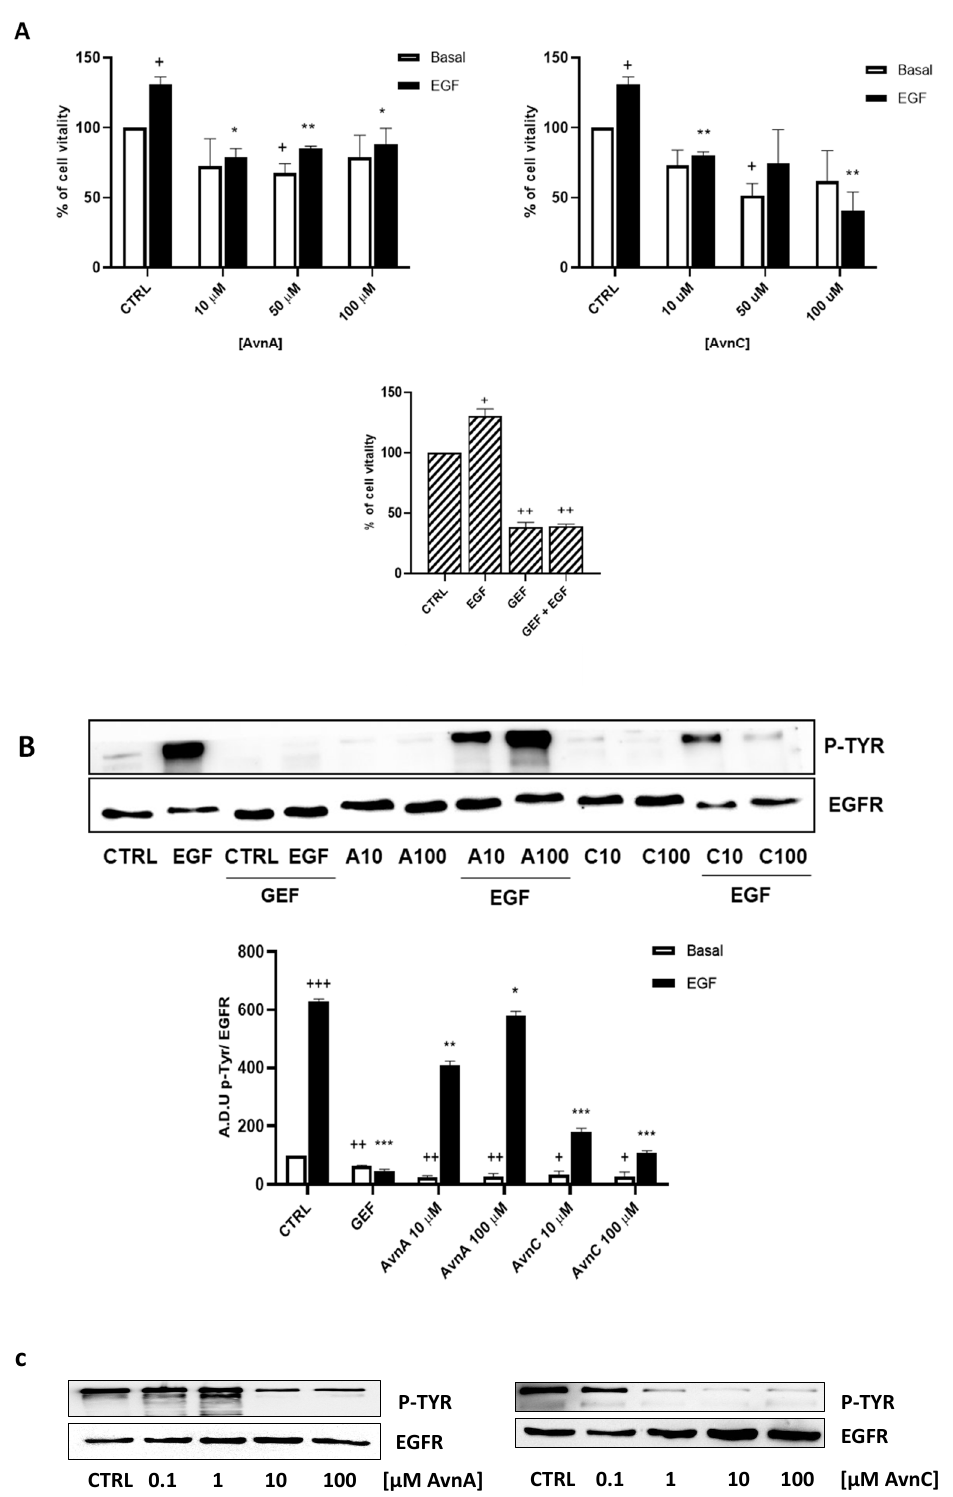
Figure 9. Effects of Avns on A431 cells vitality and EGFR phosphorylation. ( A ) MTT assay. Cells were exposed to EGF in the presence of increasing concentrations of Avns (10, 50, and 100 µ M) for three days. Data are expressed as % over basal control and are representative of three independent experiments run in triplicate. Statistical analysis: ++ p < 0.01 and + p < 0.01 vs. CTRL; ** p < 0.01 and * p < 0.05 vs. EGF. ( B ) EGFR phosphorylation. Representative images and quantification of western blot analysis in A431 cells treated with EGF in presence or absence of Avns (10 and 100 μ M). (A.D.U: arbitrary densitometry units). Data are expressed as fold increase compared to control and